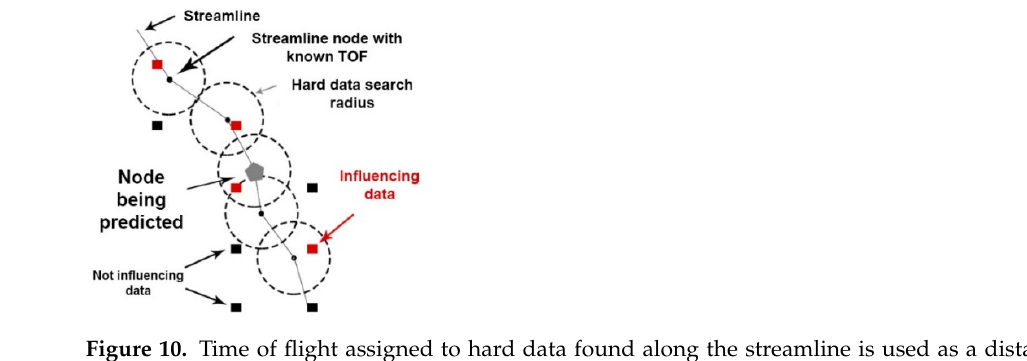
Figure 10. Time of flight assigned to hard data found along the streamline is used as a distance parameter for calculating the variogram, while influencing points are searched within given TOF distance from the streamline.